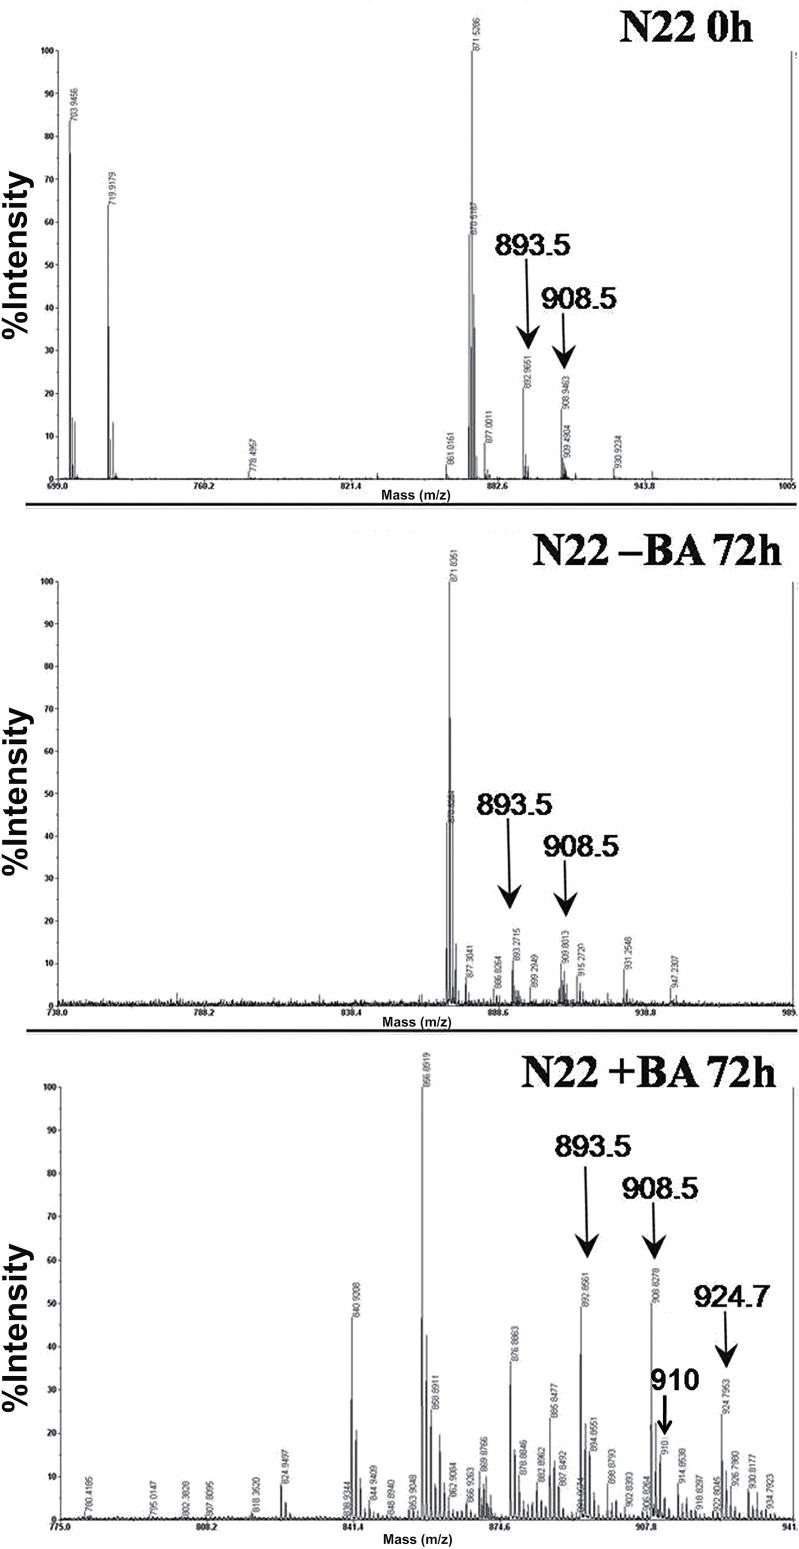
Mass spectra of HPLC-fractionated samples from N22 leaves at 0h and 72h of DIS without and with BA treatment. Three independent experiments were performed and only the consistently occurring peaks are labeled.